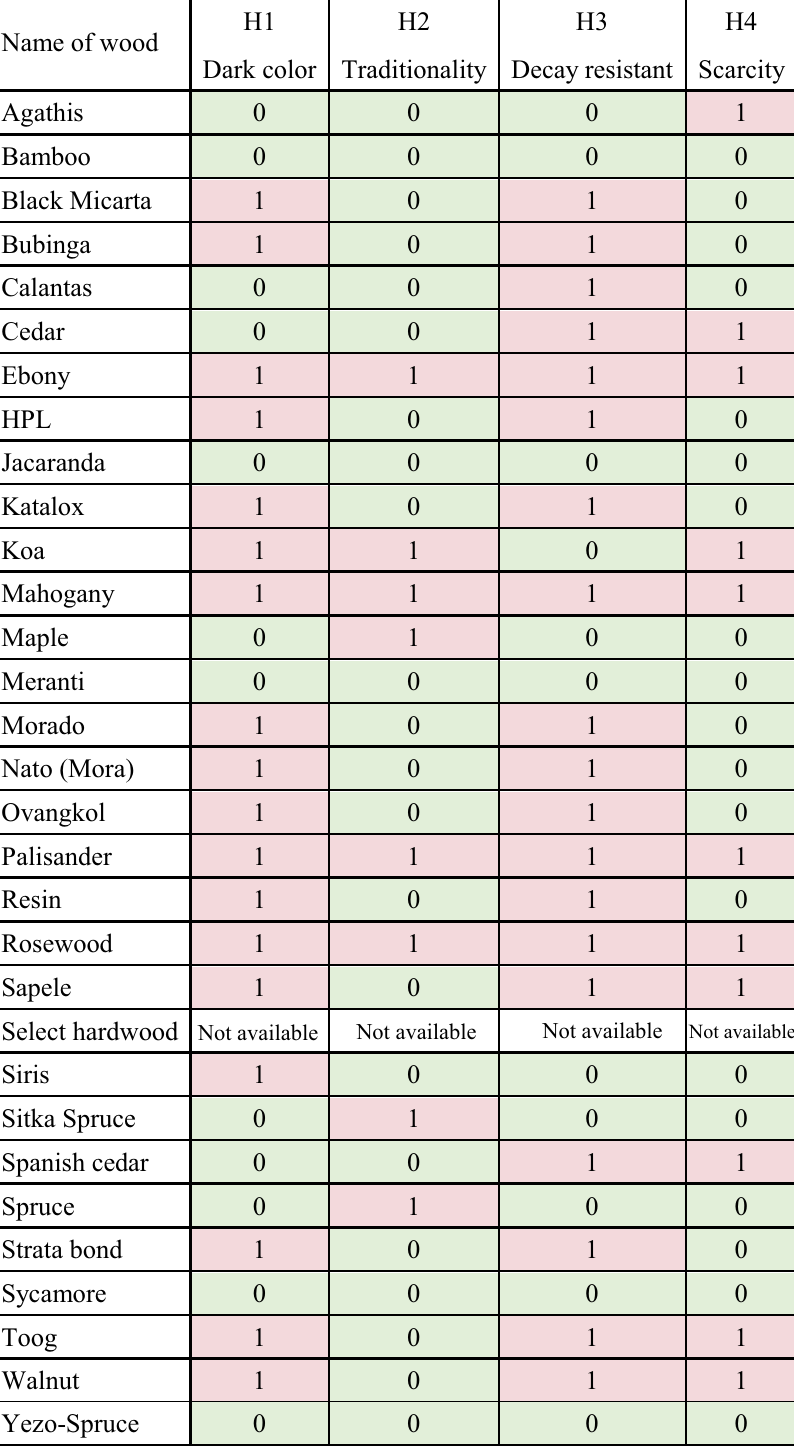
Table 2 Characteristics of wood used for acoustic guitars by attribute Name of